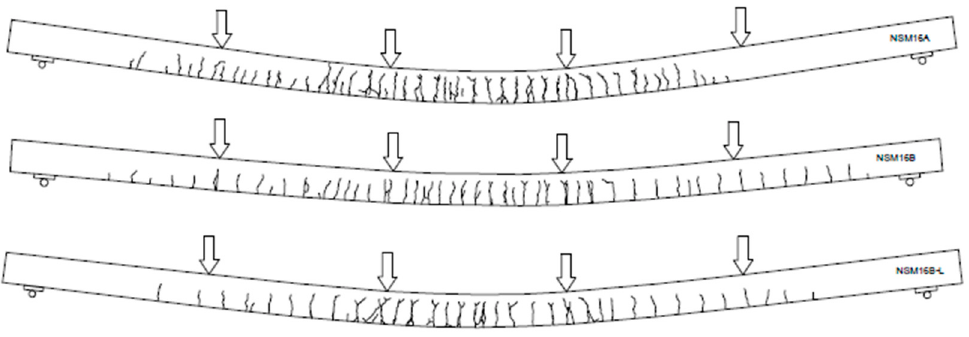
Figure 7. Cracking pattern of specimens with the higher reinforcement ratio (NSM16).